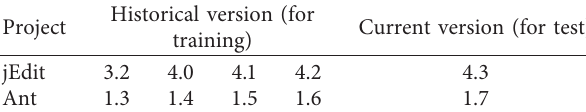
Table 1: Training sets and test sets used in the RNN. Project